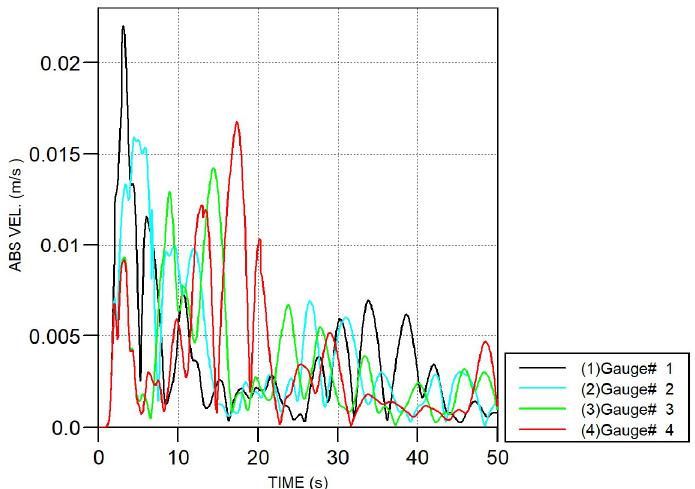
Figure 12. Vibration velocity at each gauge location set in the rock